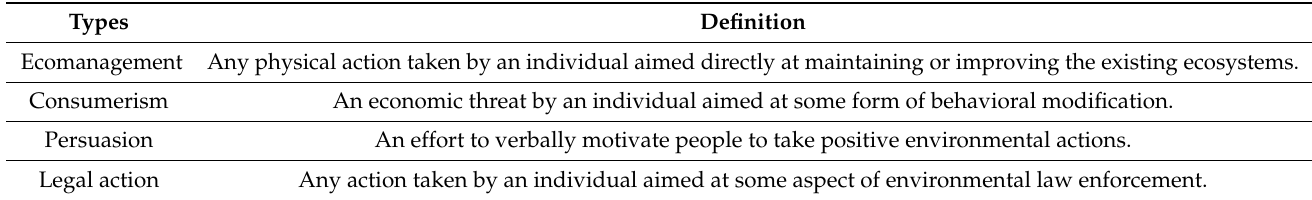
Table 2. The category of responsible environmental